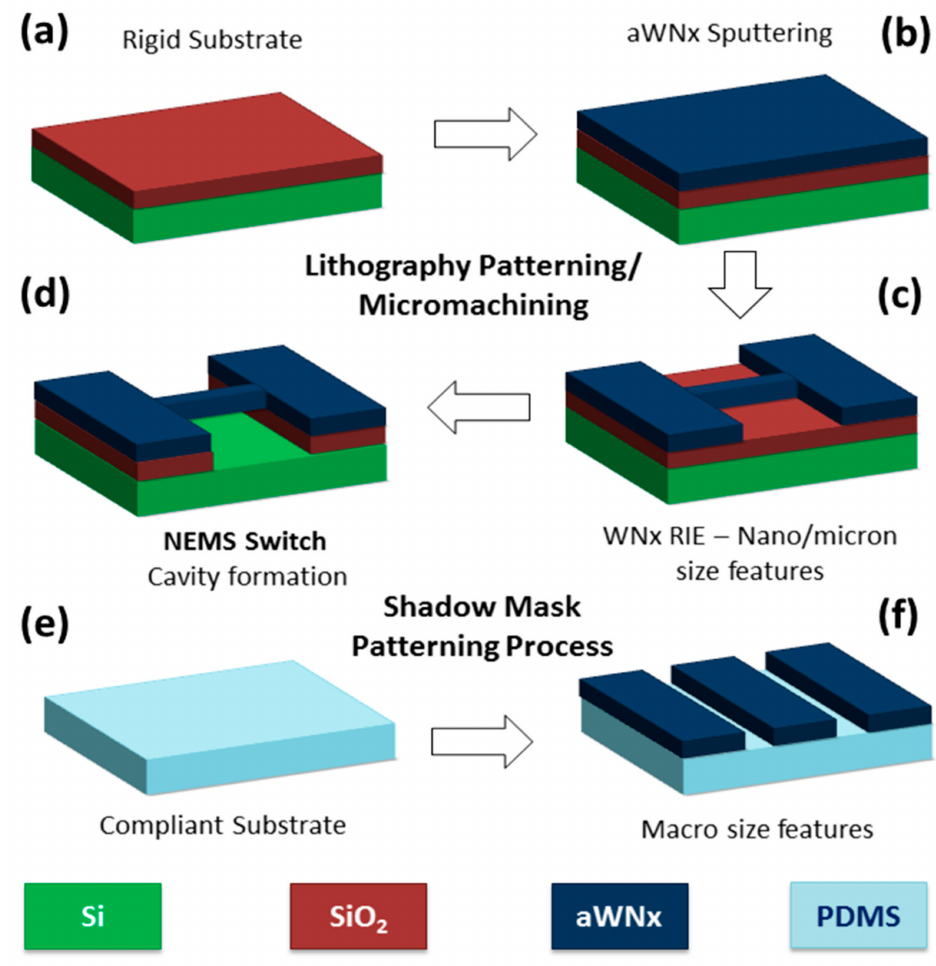
Figure 1. Two process integration sequences for amorphous WN x -based devices. ( a ) Micromachining method for small-feature-size devices starting with a rigid Si substrate with an oxide layer deposited on top using PECVD; ( b ) 100 nm amorphous WN x deposition through sputtering technique; ( c ) micro- /nano-feature patterning through lithography and RIE; ( d ) cavity formation by partially releasing SiO 2 sacrificial layer to form the final NEMS switch structure; ( e ) schematic of the shadow mask method for large structures and macro-sized features starting with a compliant PDMS substrate; ( f ) formation of desired patterns through lift-off of deposited WN x